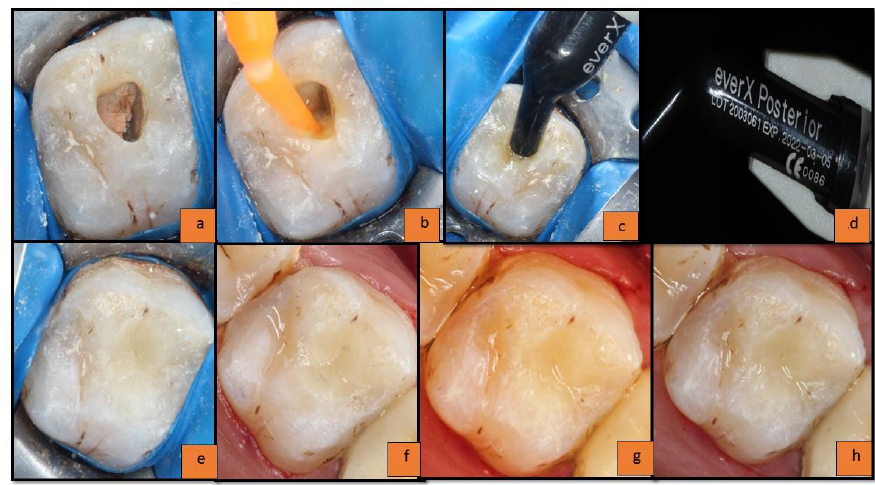
Figure 1. ( a ) Endodontically treated tooth; ( b ) application of universal bonding agent; ( c ) placement of everX posterior composite; ( d ) everX posterior composite material; ( e ) placement of solare X